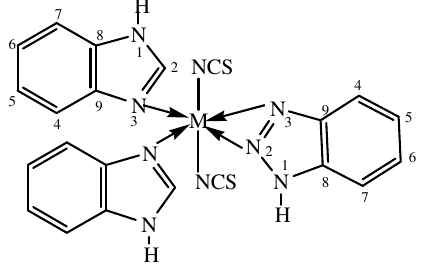
Figure 1. Octahedral geometry for the [M(BT)(BI)